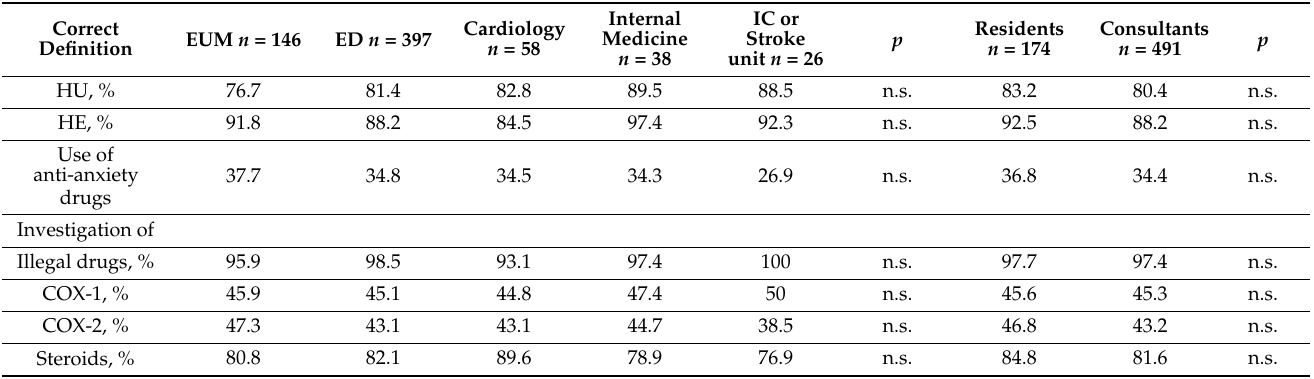
Table 1. Rates of persons who identified the correct definitions of HE and HU; who use anti-anxiety drugs to counter an acute BP rise; and who investigated the use of illegal drugs, COX-1, COX 2 and steroid drugs, according to specialty.